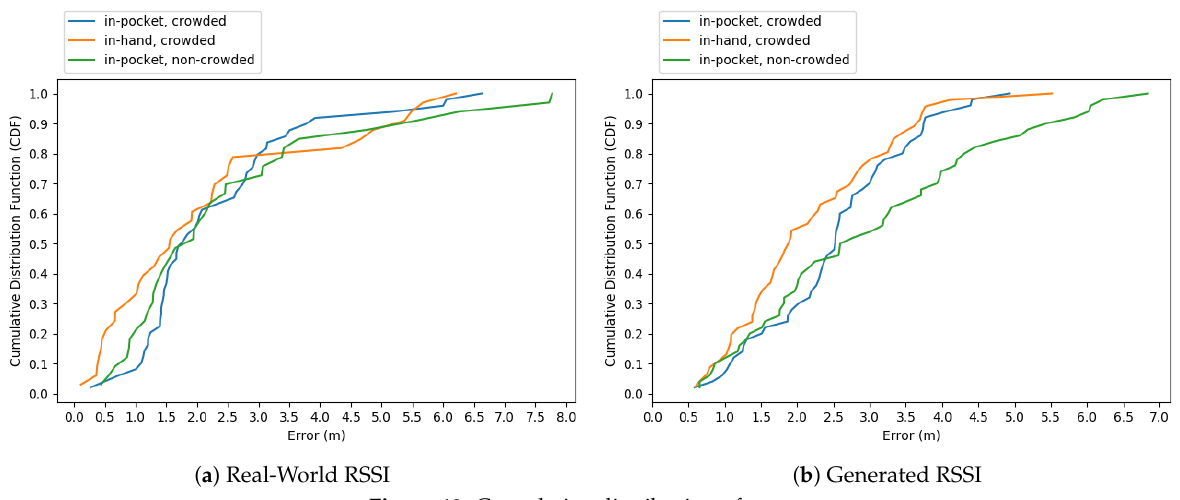
Figure 13. Cumulative distribution of